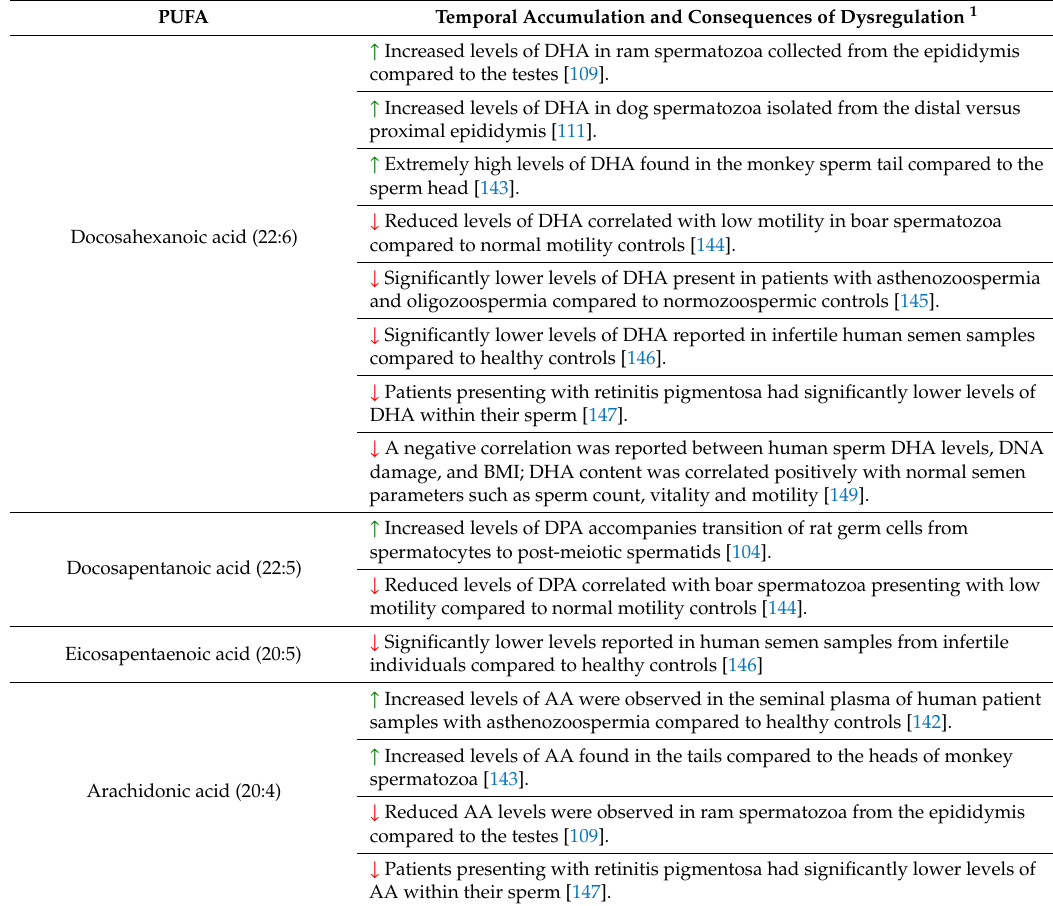
Table 2. Summary of key PUFAs represented within the male